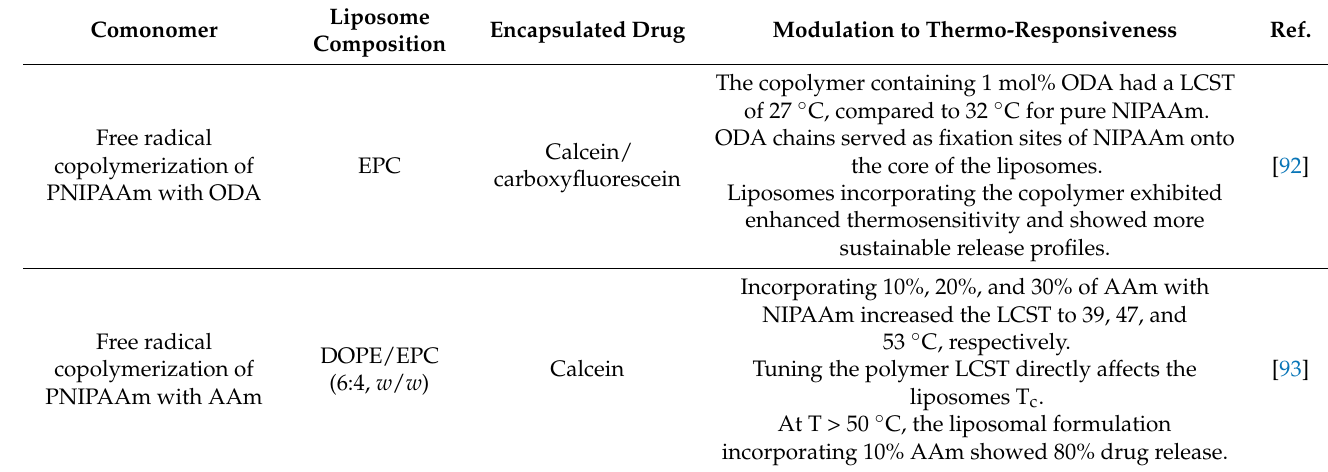
Figure 7. Hydrophilic thermosensitive polymers can ( A ) adsorb on the liposome surface, ( B ) encap- sulate the liposome, ( C , left) be covalently bonded to the polar phospholipid heads, or ( C , right) reticulate to form fused networks on the liposome surface. Amphiphilic thermosensitive liposomes either ( D , left) segregate in distinct domains, or ( D , right) uniformly distribute in the lipid bilayer. Table 4. Summary of studies on the effect of copolymerization on LCST and liposomes Tc using the polymer